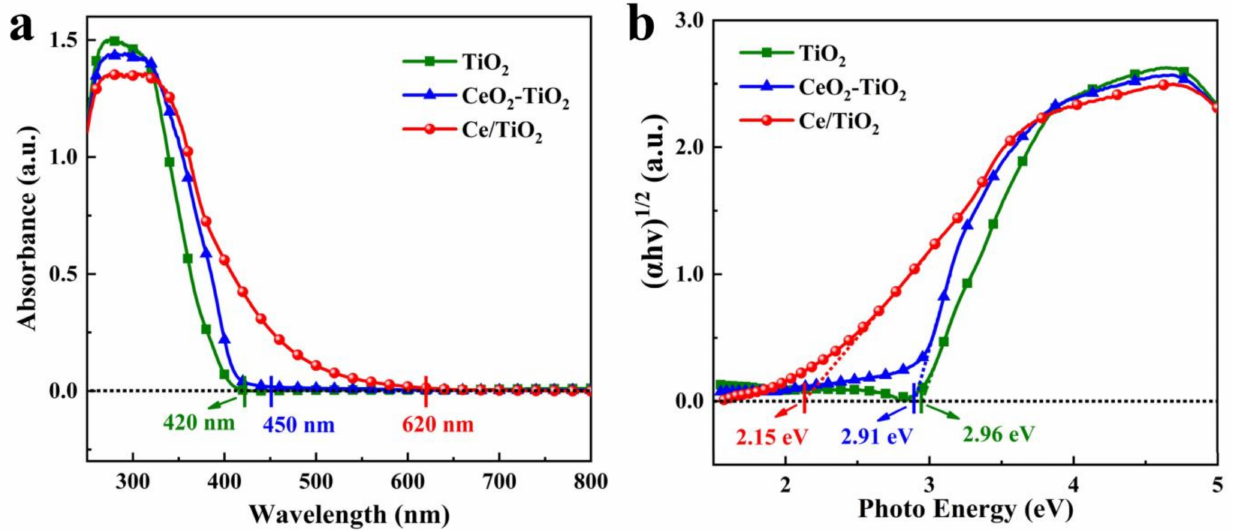
Figure 4. ( a ) UV-Vis absorbance spectra and ( b ) the corresponding Tauc plot of the pure TiO 2 , CeO 2 -TiO 2 , and Ce/TiO 2 .